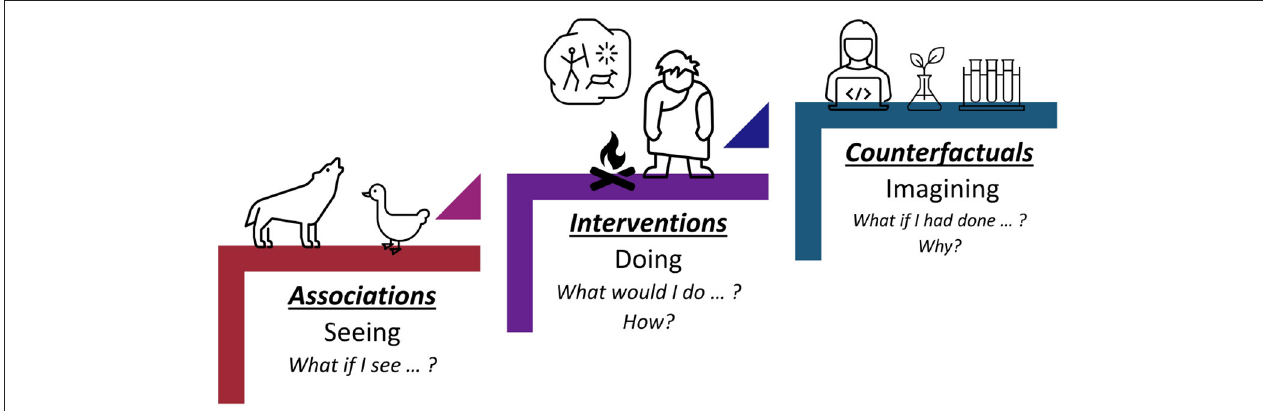
FIGURE 3 | Pearl’s Ladder of Causation. The first rung, associations, only allows predictions based on passive observations. The second rung, interventions, not only relies on seeing, but also changing what is. Rung three, counterfactuals, deals with the imaginary, or what might have